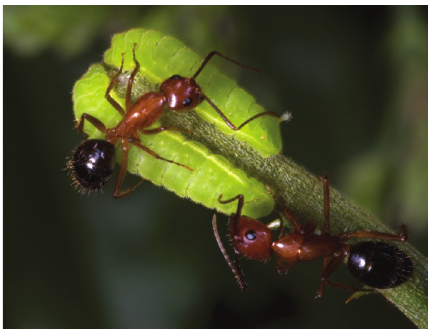
Figure 1: Camponotus floridanus workers tending two fourth